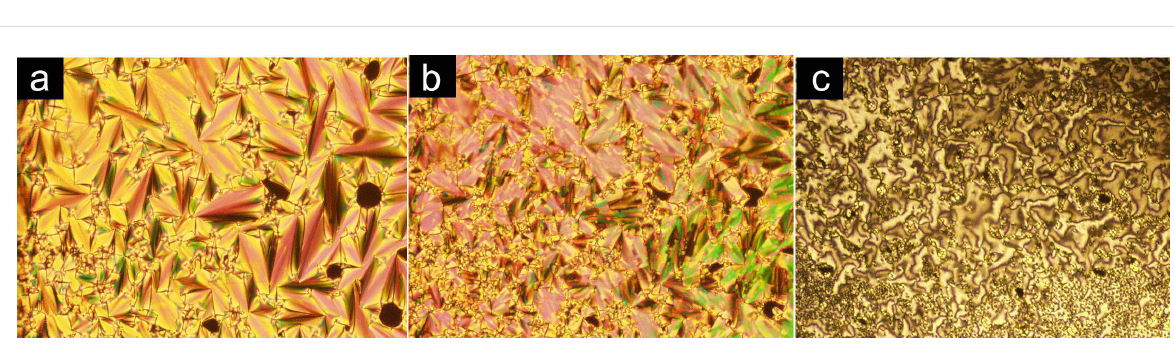
such as 19 , during periods of heating and cooling, display peaks which correspond to the transition between crystal and meso- morphic phases. Figure 3b and Figure 3c describe DSC traces for first heating and cooling curves at 10 °C/min of amides 19 and 20 . Some peaks observed during the first heating cycle are due to the thermal history of the samples. Additional